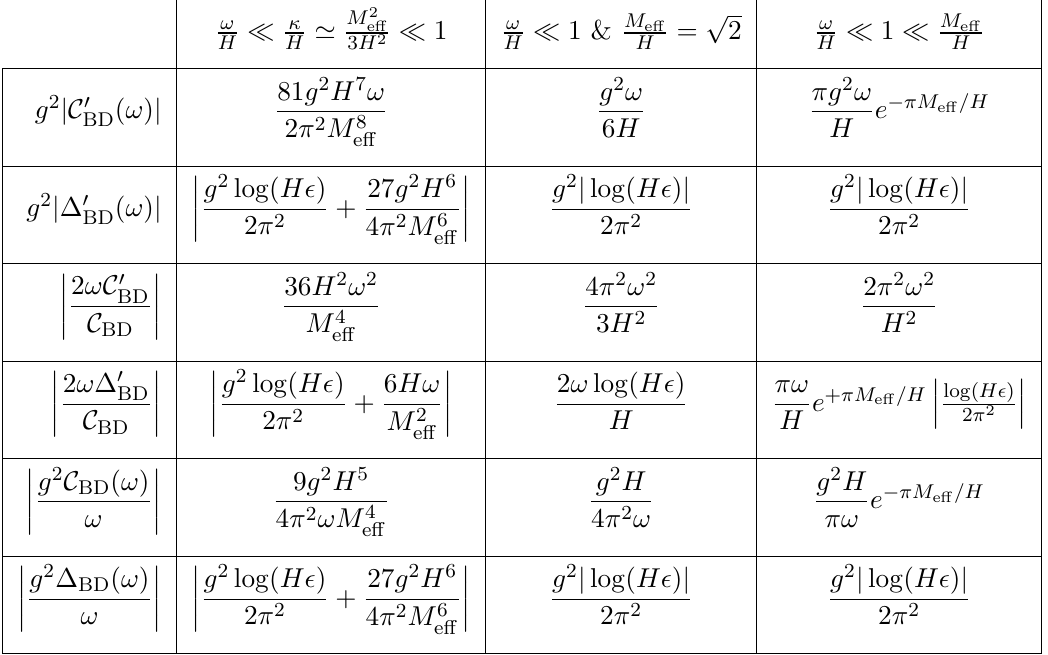
Table 4 . Leading-order behaviour for the quantities appearing in conditions (3.24) and (3.25) for the three parameter regimes that receive checks in table 3. Although the (cid:12)rst four rows here duplicate information in table 3 about the size of terms appearin in (3.24), the last two rows compare this information with the asymptotic form for the combination appearing in condition